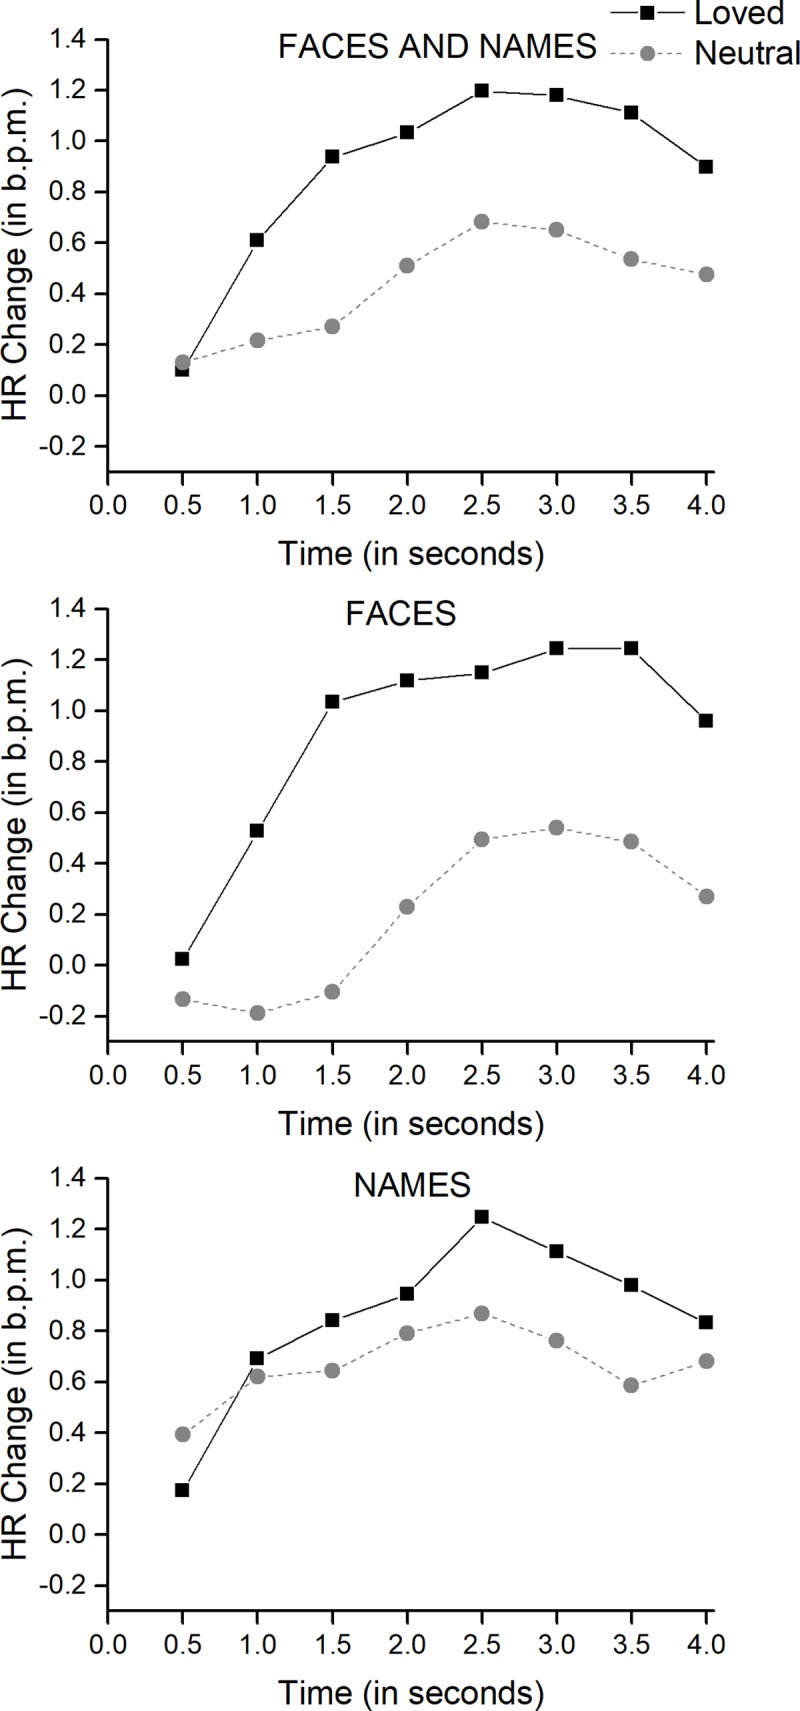
Heart Rate response to loved stimuli versus control stimuli.Top: averaged heart rate response to loved faces and names. Middle: averaged heart rate response to loved faces. Bottom: averaged heart rate response to loved names.